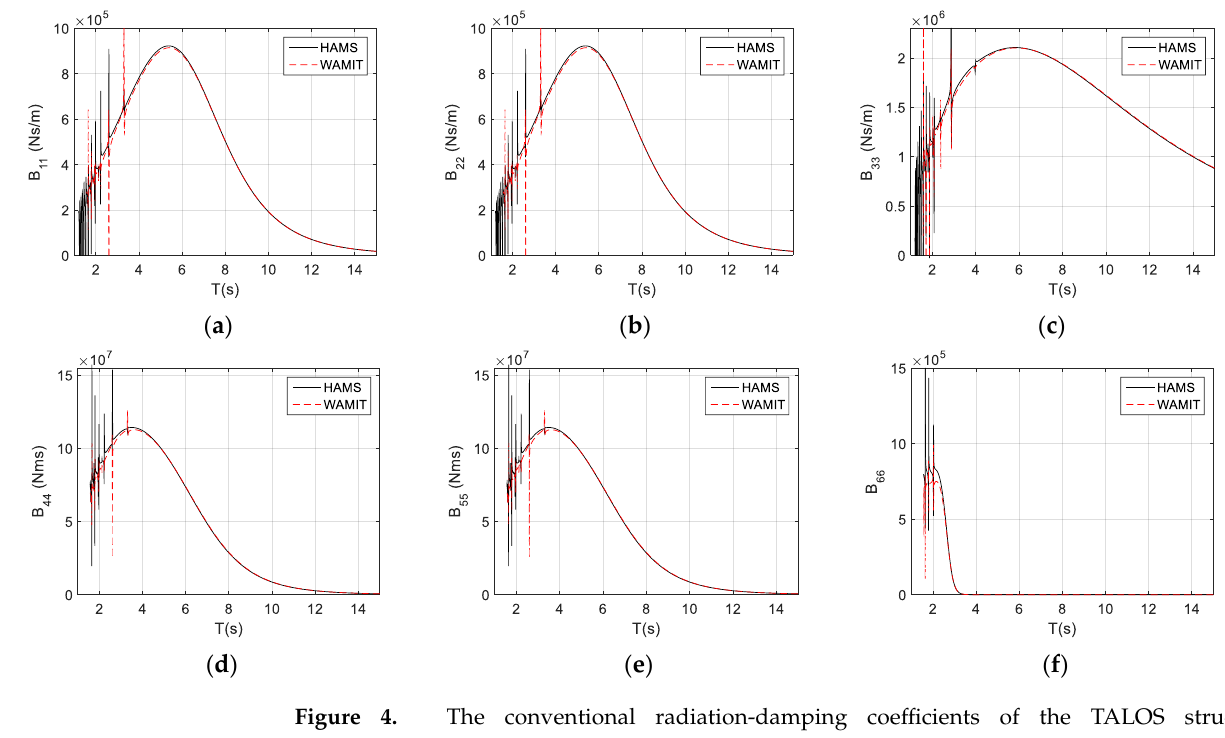
Figure 4. The conventional radiation-damping coefficients of the TALOS structure. ( a ) ; (𝐛) 𝐵 ; (𝐜) 𝐵 ; (𝐝) 𝐵 ; ( e ) 𝐵 ; (𝐟) 𝐵 𝐵 11 22 33 44 55 66 for motions of surge, sway, heave, roll, pitch, and yaw, respectively.